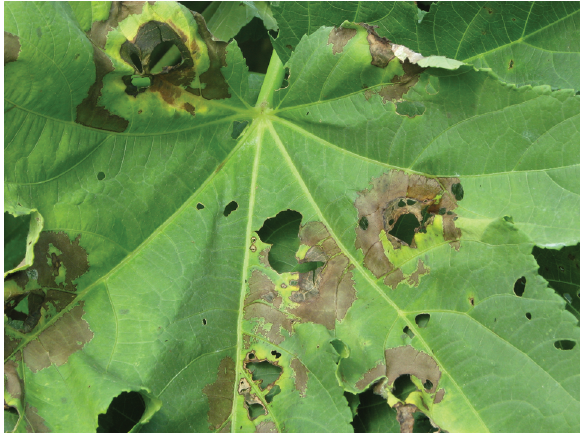
Figure 1. Symptoms of web blight ( Thanatephorus cucumeris ) on the adaxial surface of okra leaves.